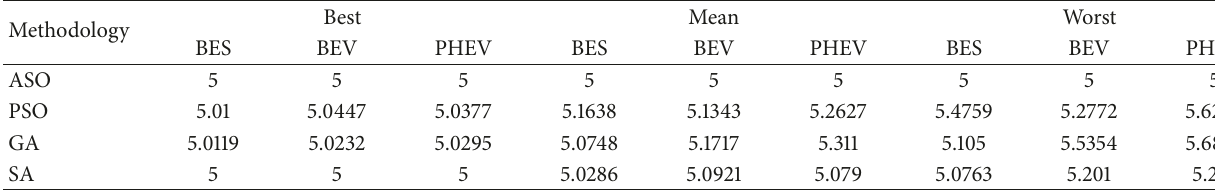
Table 10: Optimized capacities of batteries in Case 1.